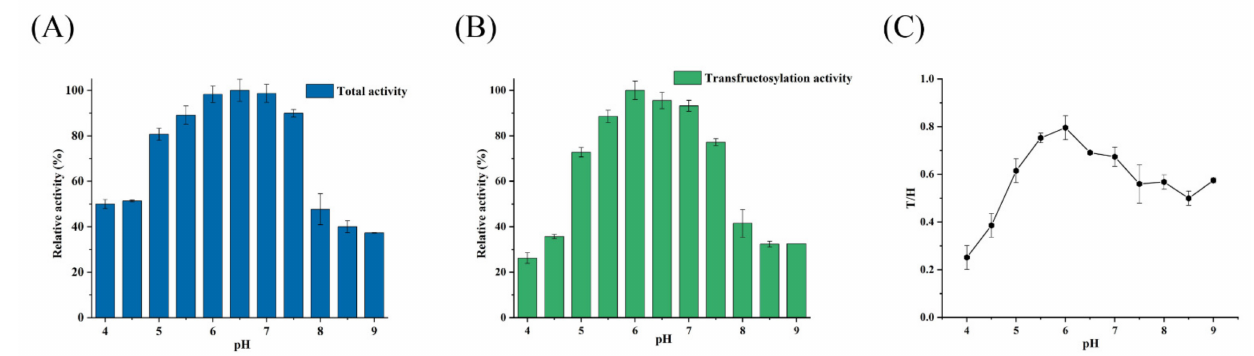
Figure 3. Effect of pH on the activity and T/H of the recombinant LS. ( A ) Effect of pH on the total activity of Psor-LS. ( B ) Effect of pH on the transfructosylation activity of Psor-LS. ( C ) Effect of pH on the T/H of Psor-LS. All of the values were the mean of triplicate experiments.